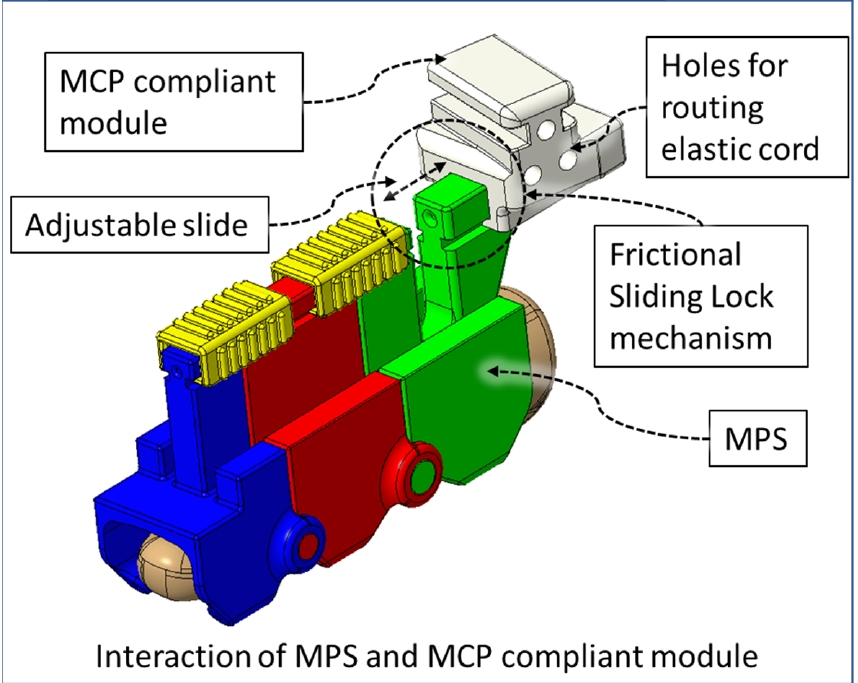
Figure 6. Frictional sliding lock between MPS and MCP compliant module. The four MCP-compliant modules are connected via a general-purpose elastic cord. One elastic cord of Ø2.5 mm diameter is routed through the compliant modules that pass through three holes in each module and is locked at the outer side of the index and small finger’s MCP modules. The use of a single elastic cord allows uniform force distribution through all four fingers’ MCP-compliant modules during passive compliance of MCP abduction–adduction during MCP flexion–extension motion. The frictional sliding lock in the MCP-compliant modules’ slots are angled so that all four fingers are spread out during fingers’ extension. This reduces interference due to friction between two adjacent exoskeletal shells. The orientation of the MCP-compliant mechanism can be seen in Figure 7a,b. The elastic cord is tensioned so that during the finger extension motion, unless externally actuated, the MCP compliant modules pull towards each other, keeping the fingers apart (Figure 7a). During MCP flexion of fingers, the changing gap between adjacent finger exoskeletons is passively accommodated by the MCP-compliant mechanism MCP-compliant module with an oriented frictional sliding lock for the connecting